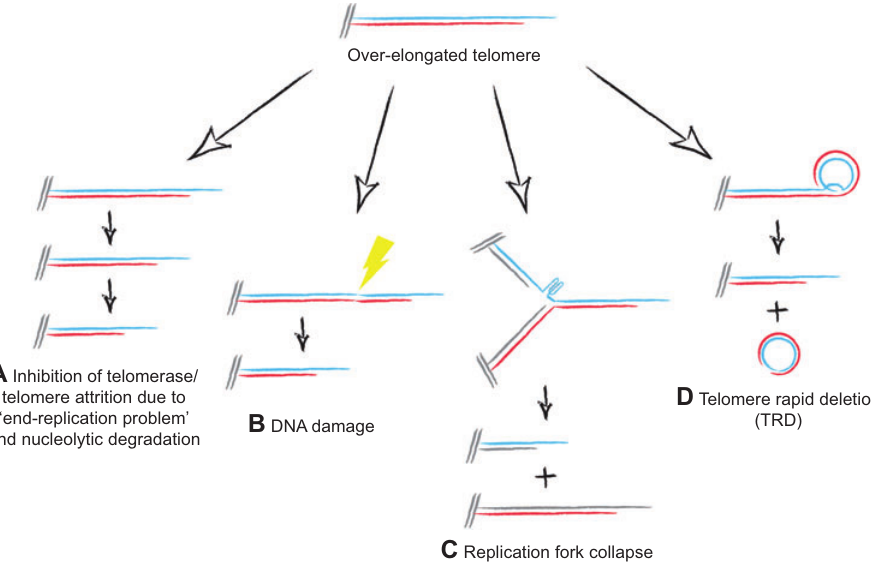
Figure 1 Shortening over-elongated telomeres. (A) In the absence of telomerase, or when telomerase activity is inhibited, telomeres shorten due to a combination of incomplete DNA